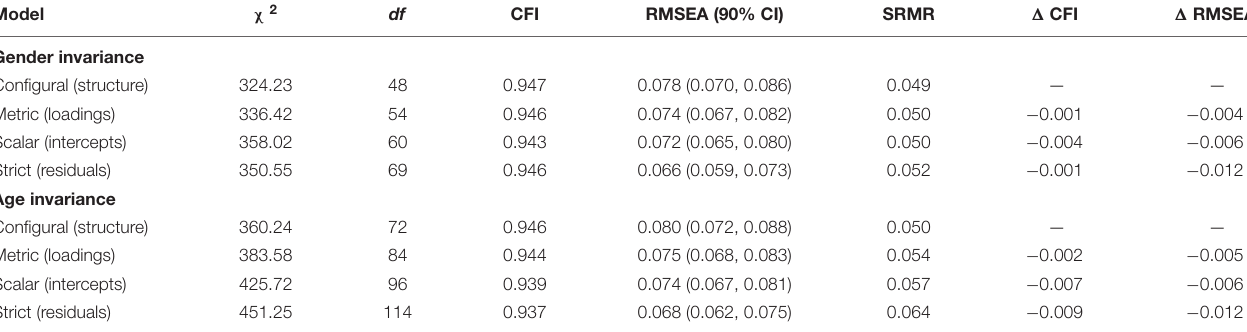
TABLE 3 | Fit indices for measurement invariance of the original HEMA scale (9 items). Model